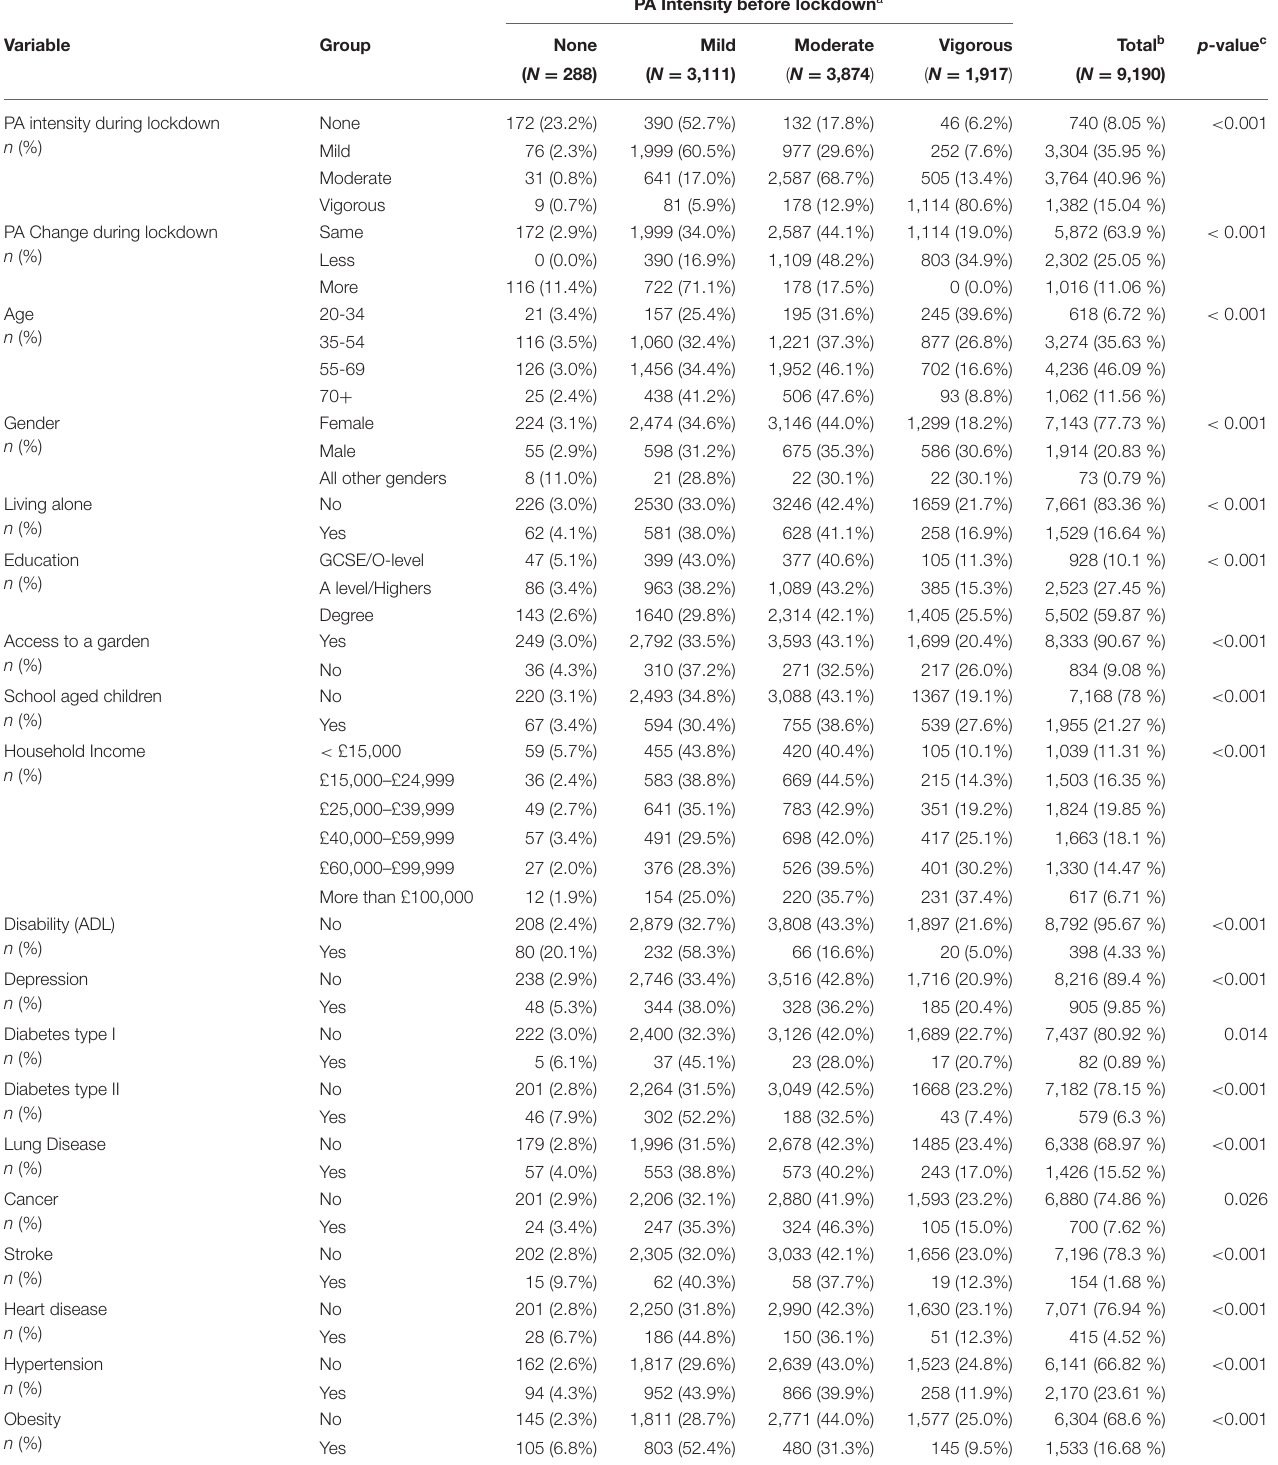
TABLE 1 | Demographic characteristics of the sample, by baseline PA